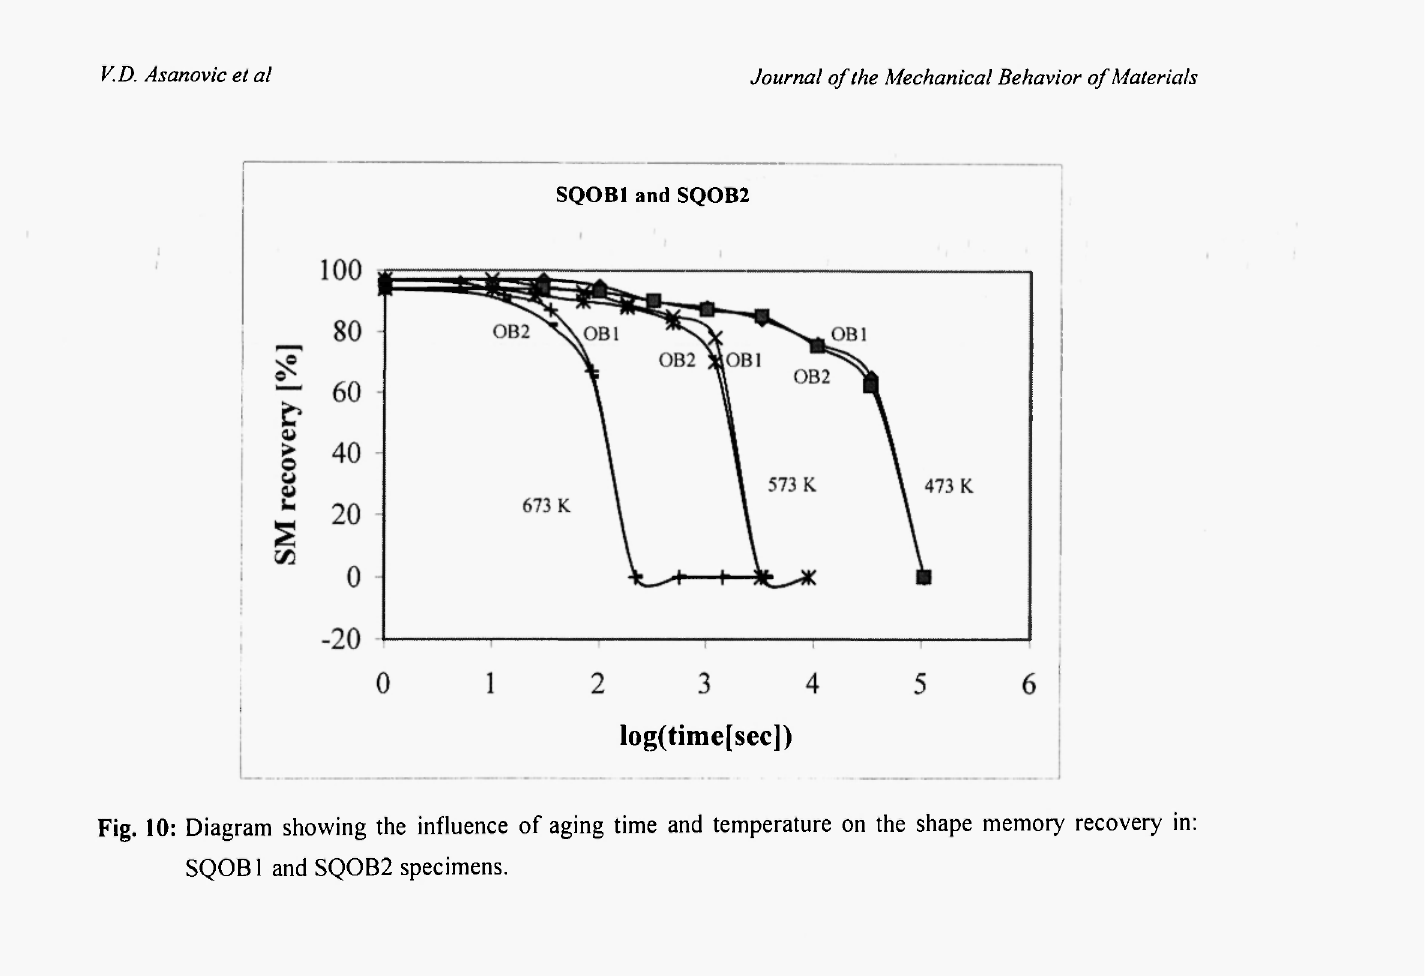
Fig. 10: Diagram showing the influence of aging time and temperature on the shape memory recovery in: SQOB1 and SQOB2